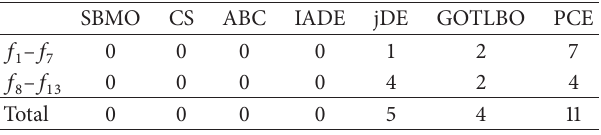
Table 4: The number of the optimal performances on 13 standard benchmark functions.